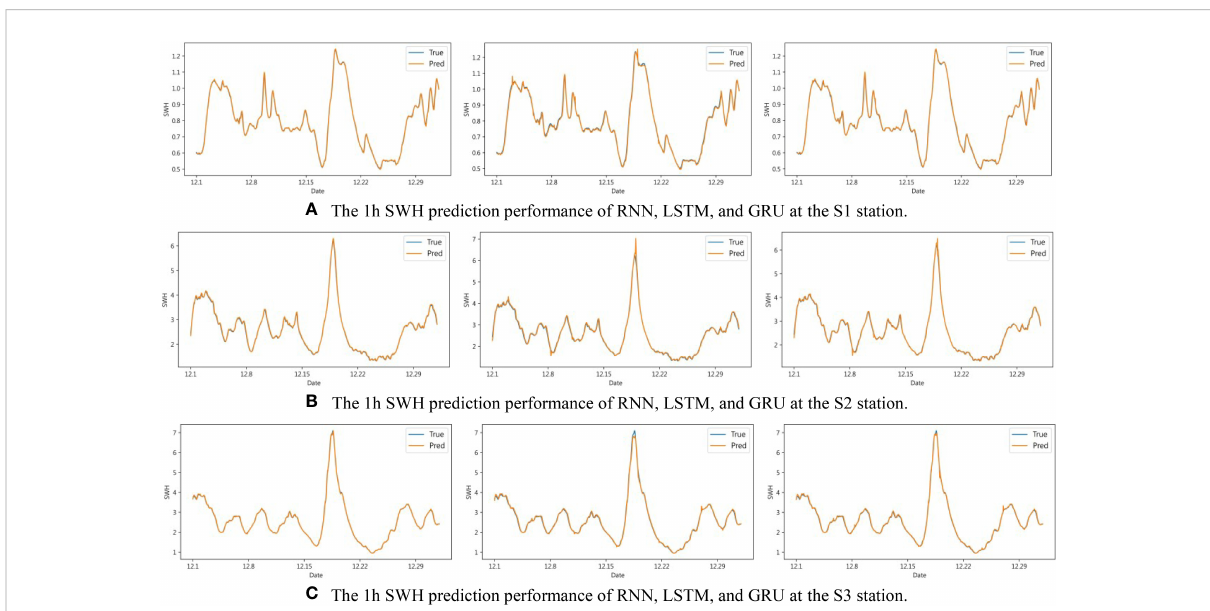
FIGURE 6 1h SWH prediction performance of RNN, LSTM, and GRU at S1, S2, and S3. (A) The 1h SWH prediction performance of RNN, LSTM, and GRU at the S1 station. (B) The 1h SWH prediction performance of RNN, LSTM, and GRU at the S2 station. (C) The 1h SWH prediction performance of RNN, LSTM, and GRU at the S3